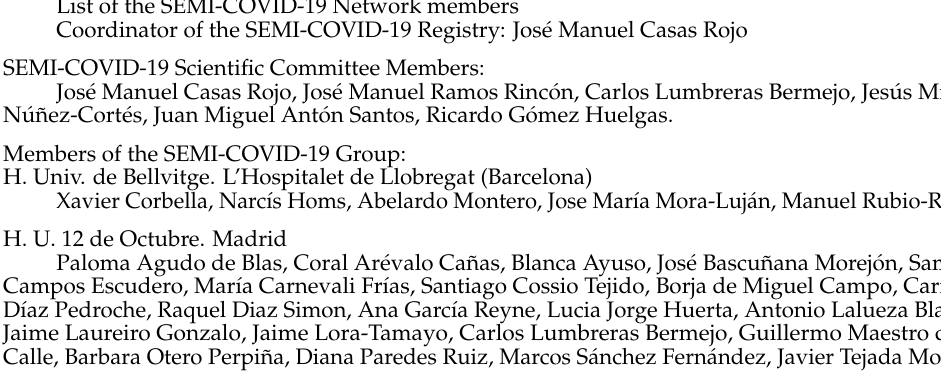
criteria; Table S2. Risk factors of the requirement of HFNC; Table S3. Risk factors of the requirement of NIMV; Table S4. Risk factors of the requirement of IMV; Table S5. Risk factors of ICU admission; Table S6. Matrix of correlations between prognostic